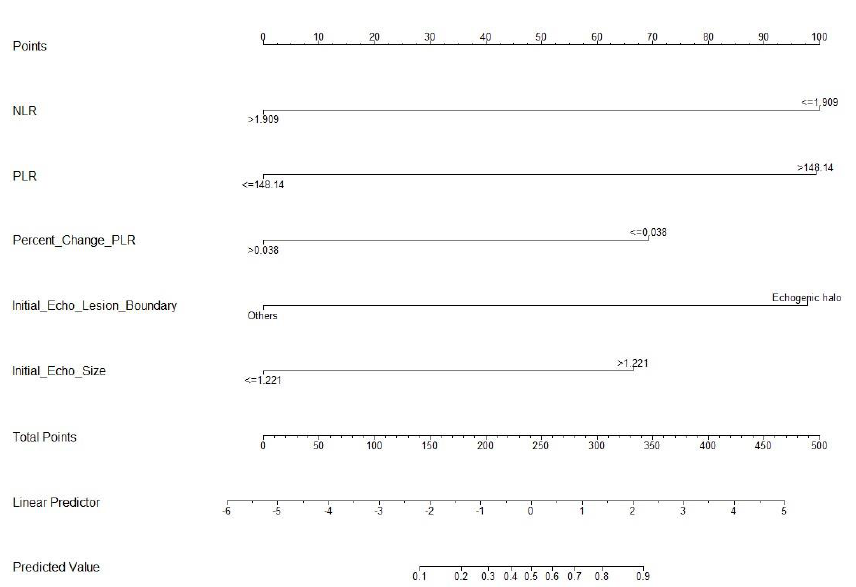
Figure 2. Nomogram for prediction of pCR in TNBC patients receiving NAC. NLR: neutrophil-to- lymphocyte ratio. PLR: platelet-to-lymphocyte ratio. Initial_Echo_Size: H/W ratio (tumor height-to-width ratio).